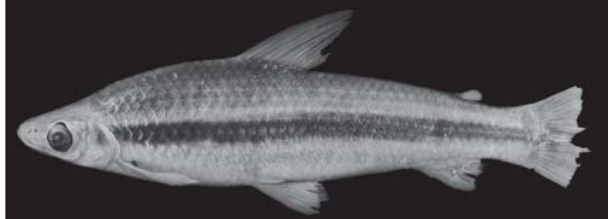
Fig. 21. Adult specimen of Laemolyta proxima , MZUSP 64066, 132.1 mm SL; Brazil, Pará, rio Trombetas, Lago Jacaré.